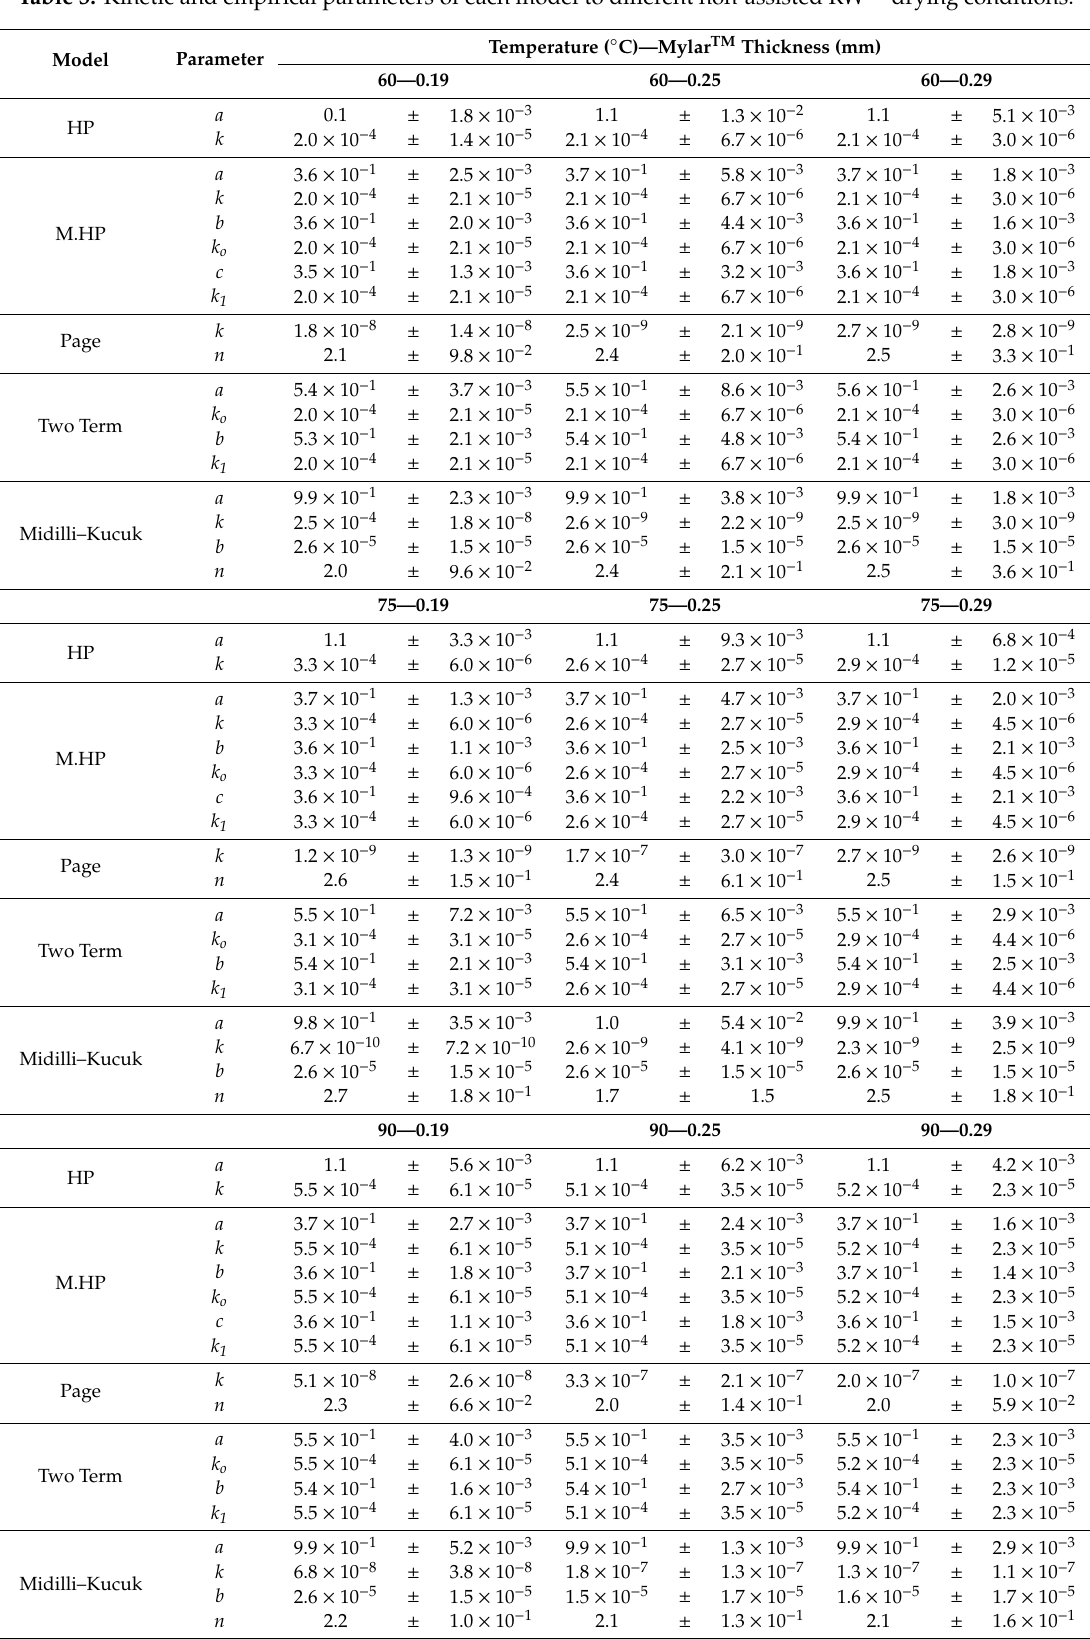
Table 3. Kinetic and empirical parameters of each model to di ff erent non-assisted RW ™ drying conditions.